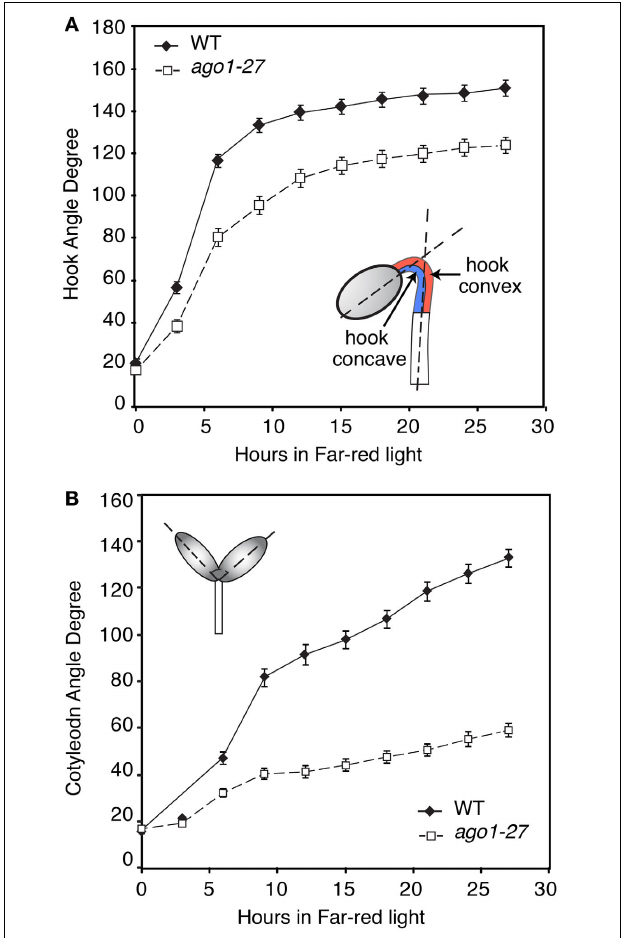
FIGURE 1 | Angle of cotyledon and hook in ago1-27 mutants compared to background accession during growth under continuous far-red light (FRc). Three-day old etiolated seedlings ago1-27 seedlings and the corresponding wild-type background accession Columbia (WT) were transferred to FRc. The angles of hook (A) and cotyledon (B) of both mutants and WT were measured from photographs taken at 3h intervals. The error bars represent the standard error of the